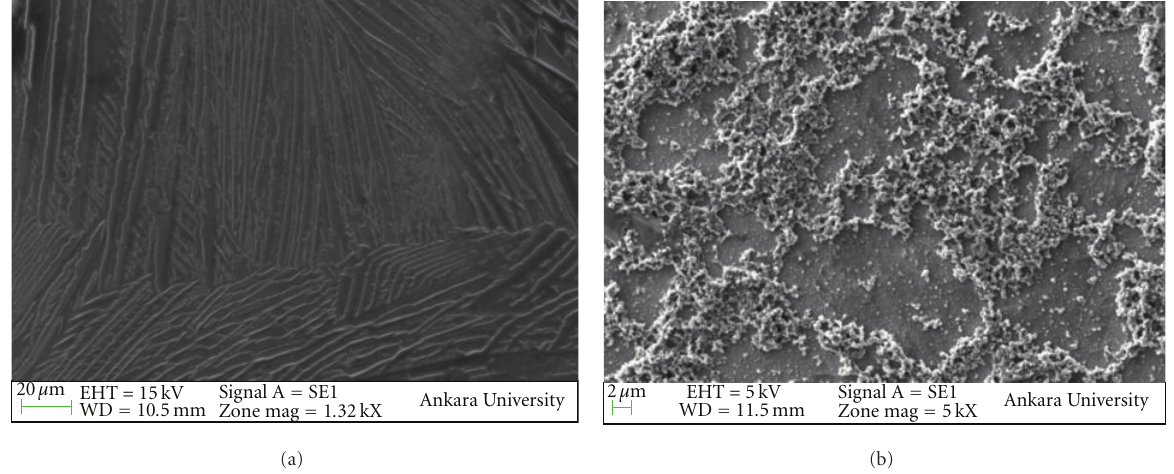
Figure 3: SEM images of (a) PANI and (b) PANI/gold nanorod composite electrode.